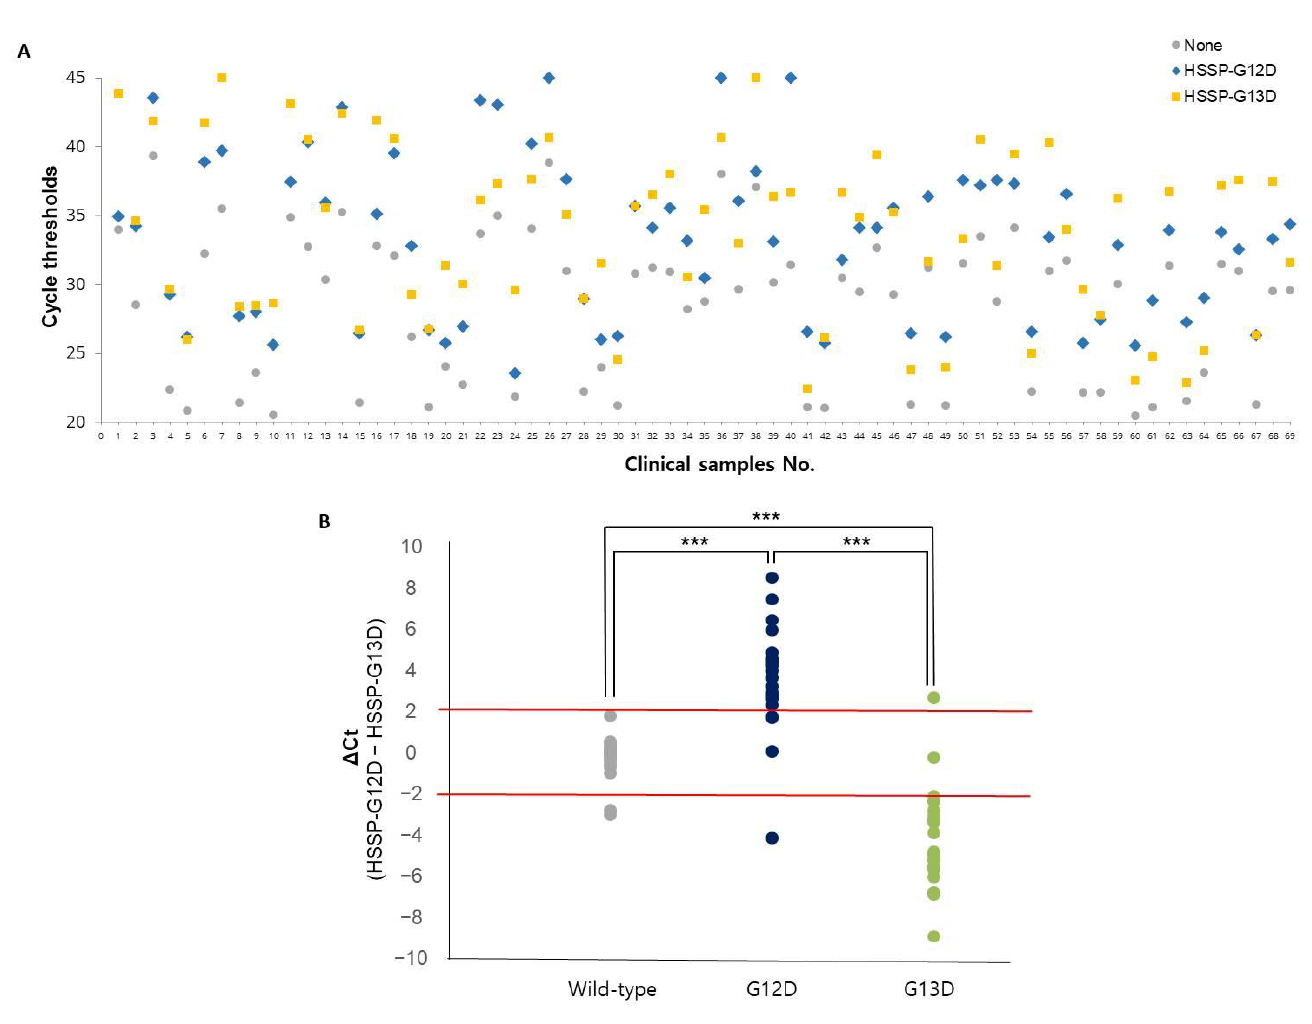
Figure 4. Application of the KRAS mutations detection in 69 clinical samples . ( A ) C t values using HSSP with qPCR in 69 clinical samples. The colors represent HSSP-G12D (blue), HSSP-G13D (yellow), and without HSSP (gray). ( B ) Mutation detection using ∆ C t range (2, − 2). Based on the type of sample by BRC, wild-type (gray), G12D type (deep blue), and G13D type (green). The standard for the mutation classification is ∆ C t range (2, − 2). Significant differences between groups are indicated; *** p <